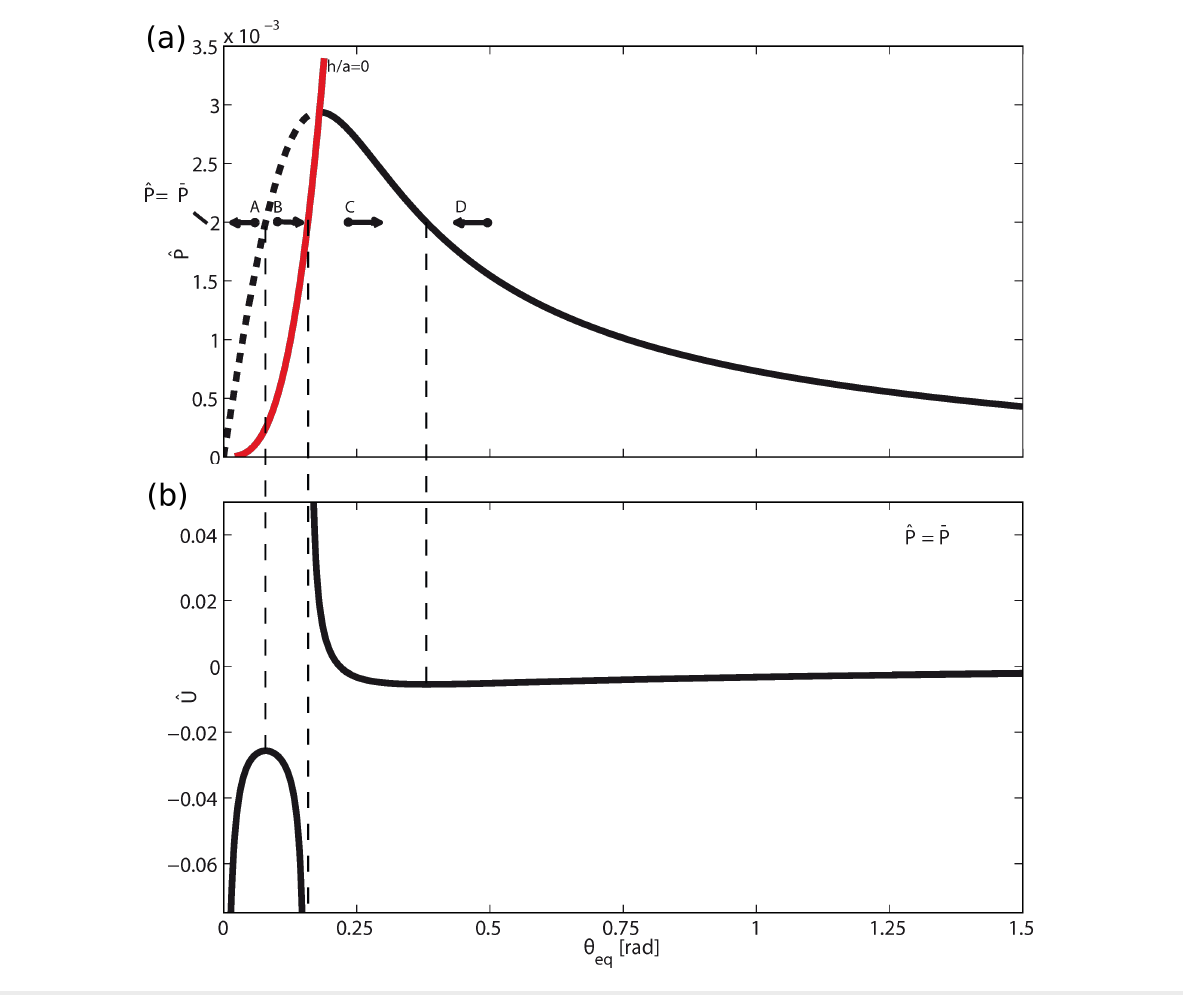
Figure 2: The dimensionless peeling force as a function of the peeling angle θ eq at equilibrium (a); the total energy as a function of the peeling angle θ even out of equilibrium (b). For a fixed peeling force, depending on the initial configuration of the tape, the system can evolve towards states of partial adhesion (points C and D ), complete detachment (point B ) or can fail before reattaching to the substrate (point A ).